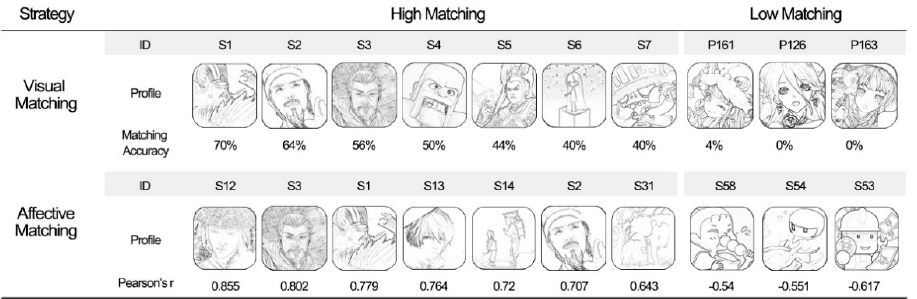
Figure 5. Strategy game icons with high perceptual matching.